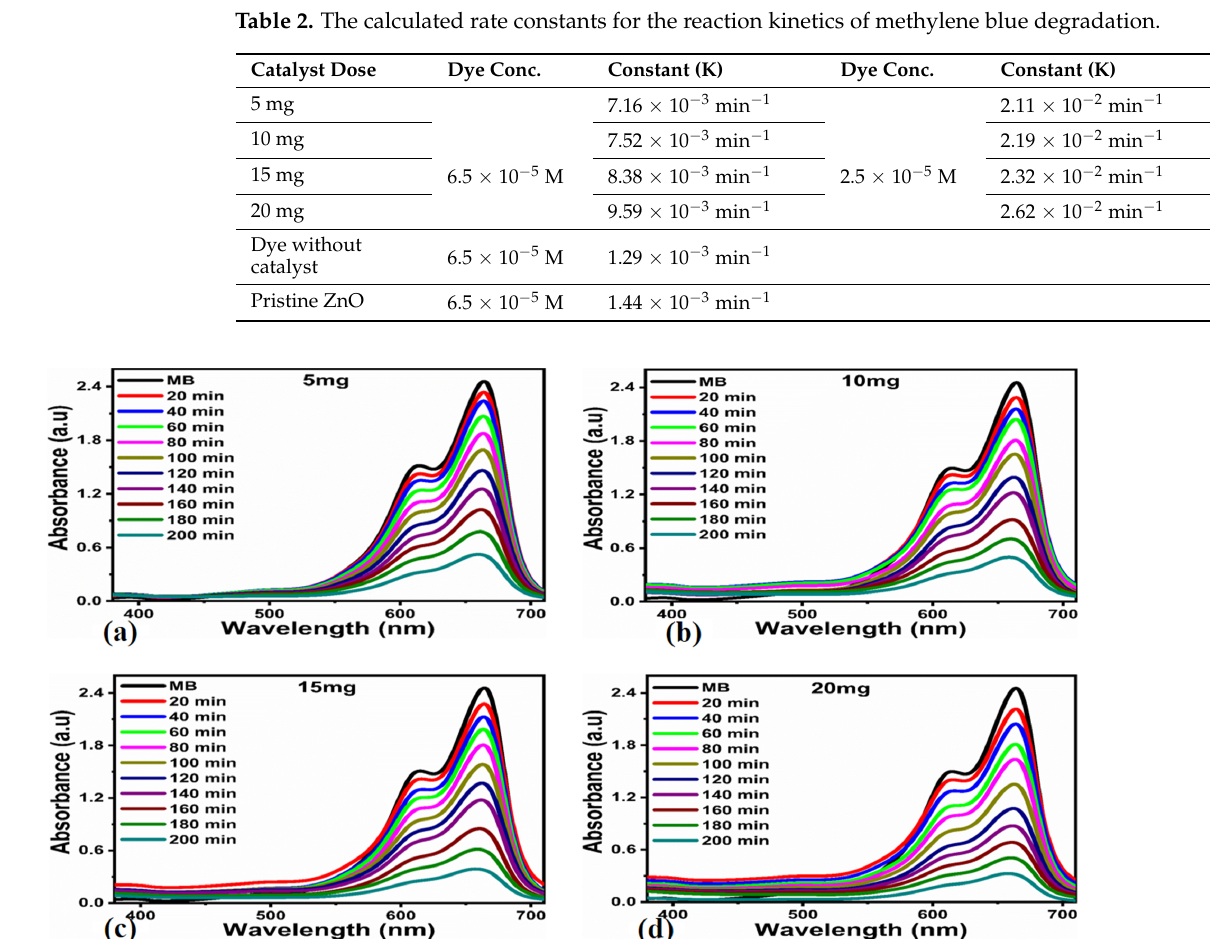
Figure 9. High concentration absorption spectra under UV irradiation for psyllium-added ZnO with various concentrations of 5 mg ( a ), 10 mg ( b ), 15 mg ( c ), and 20 mg ( d ).